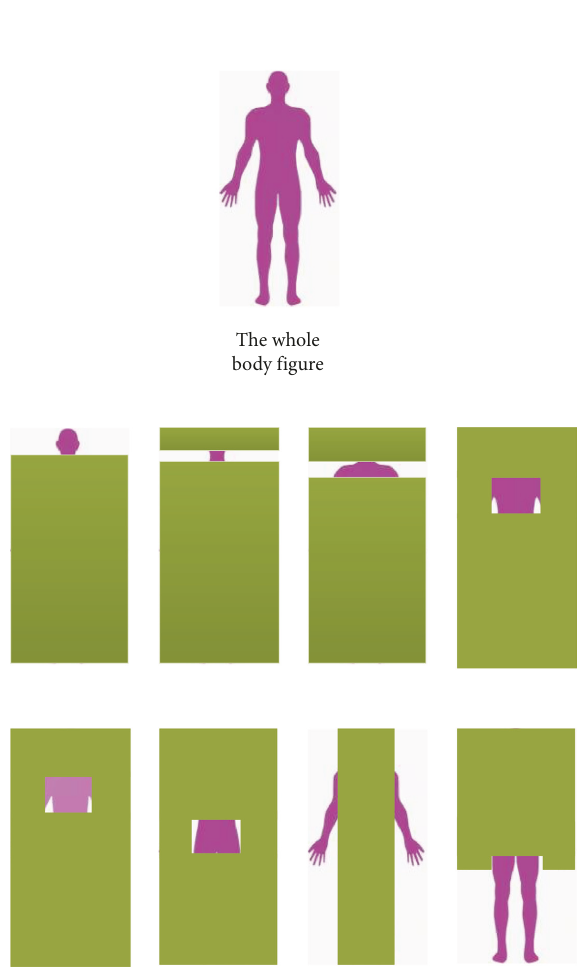
Figure 1: Multiregion contour template partitioning